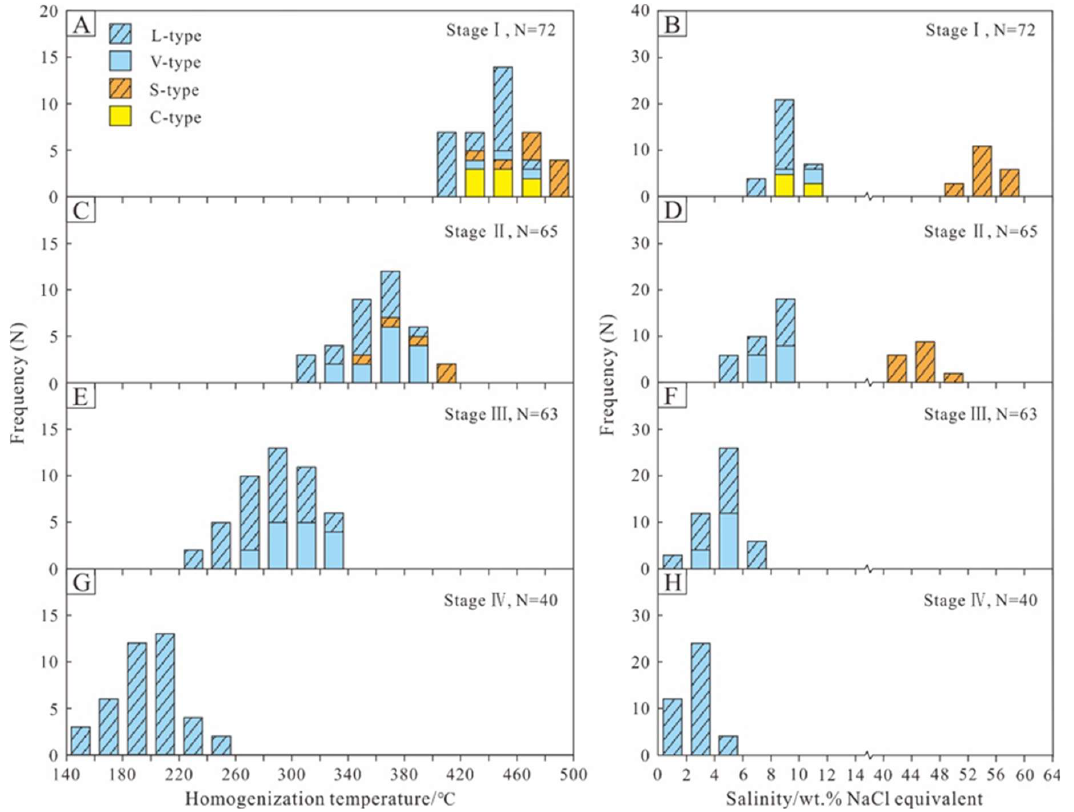
Figure 6. Frequency histograms of the total homogenization temperatures (Th) and salinities of FIs (wt.% NaCl equivalent) in four mineralization stages from the Huoluotai Cu (Mo) deposit. ( A ) Homogenization temperatures histogram for L-, V-, S-, and C-type FIs from stage I quartz; ( B ) Salinities histogram for L-, V-, S-, and C-type FIs from stage I quartz; ( C ) Homogenization temperatures histogram for L-, V-, and S-type FIs from stage II quartz; ( D ) Salinities histogram for L-, V-, and S-type FIs from stage II quartz; ( E ) Homogenization temperatures histogram for L- and V-type FIs from stage III quartz; ( F ) Salinities histogram for L- and V-type FIs from stage III quartz; ( G ) Homogenization temperatures histogram for L-type FIs from stage IV quartz; ( H ) Salinities histogram for L-type FIs from stage IV